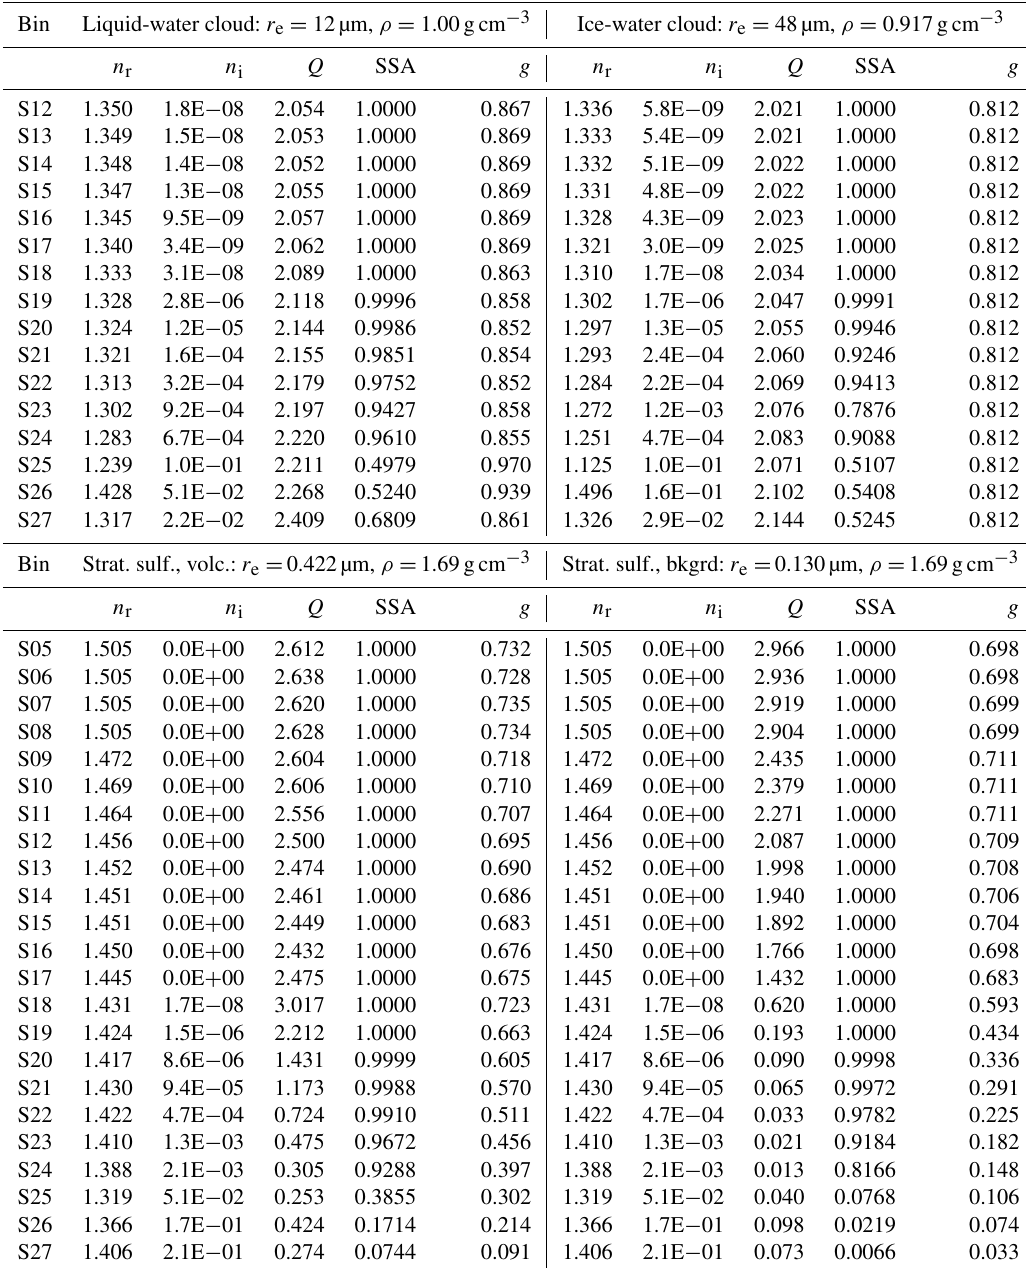
Table 2. Spectral properties of liquid-water and ice-water clouds and stratospheric sulfate aerosols: the real and imaginary refractive indices ( n r and n i ) , ratio of optical to geometric cross section ( Q ), single scattering albedo (SSA), and the asymmetry factor ( g